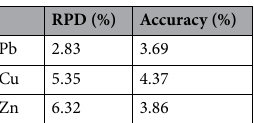
Table 1. Relative percentage difference and accuracy of analytical results of studied